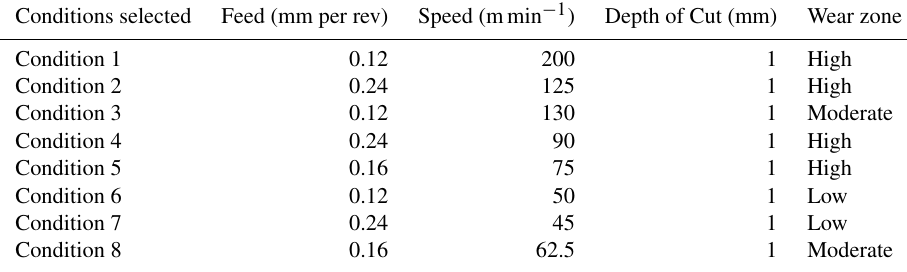
Table 3. Process parameters selected from the maps.